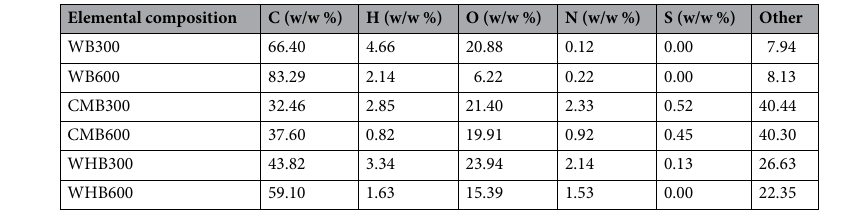
Table 2. Elemental composition of in-house produced biochar